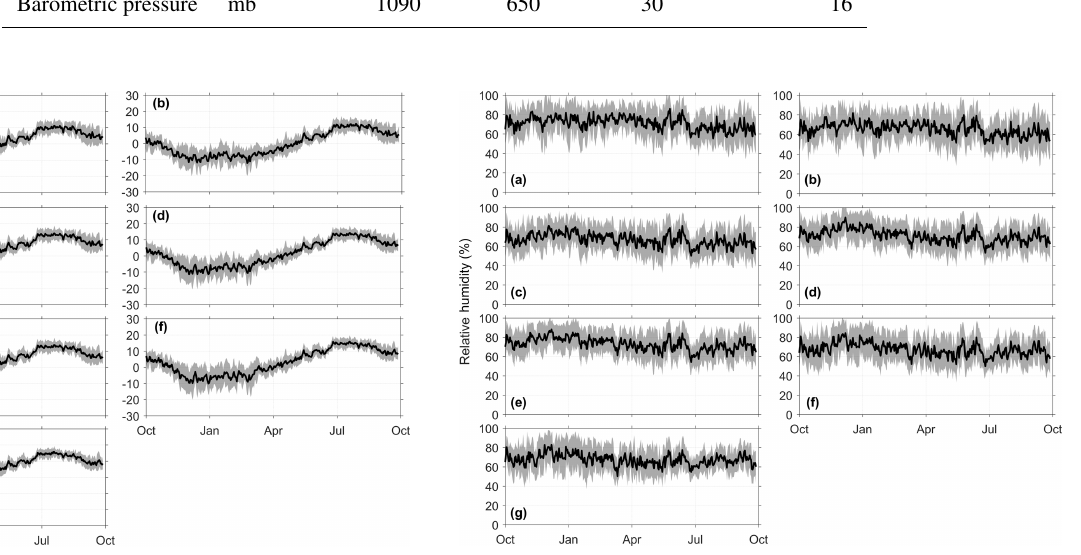
Figure 5. Annual mean daily relative humidity for 11 water years from 1 October 2005 to 30 September 2016 at MCRB stations: (a) Centennial Ridge, (b) Fisera Ridge, (c) Vista View, (d) Upper Clearing, (e) Upper Forest, (f) Level Forest, and (g) Hay Meadow. The line represents the annual mean and the shaded area represents the standard deviation of the 11-year daily relative